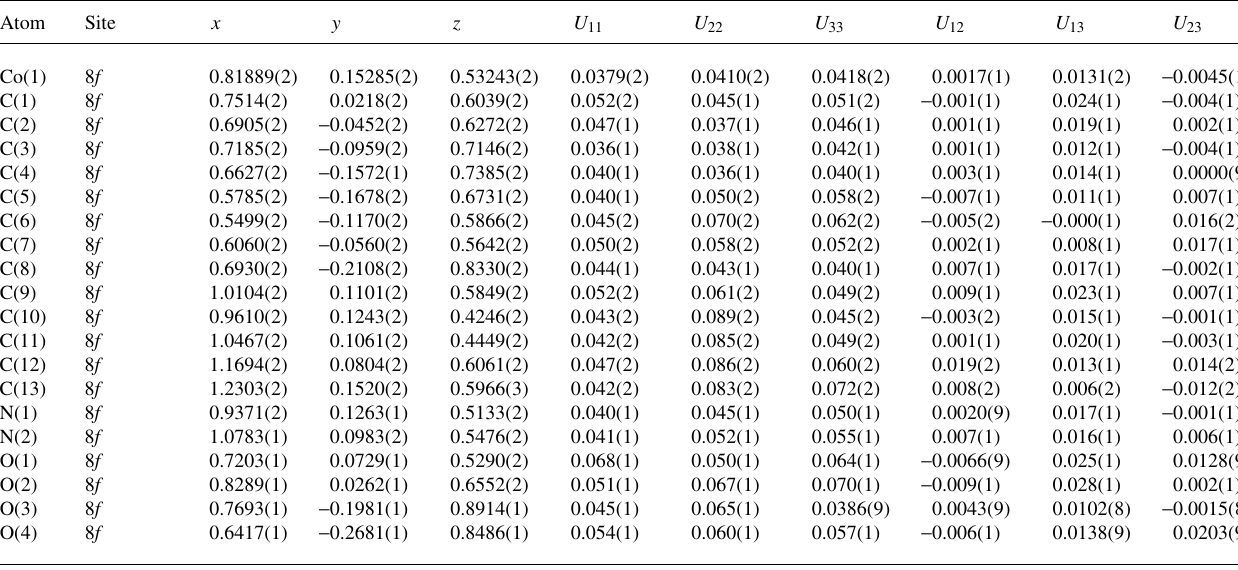
Table 3. Atomic coordinates and displacement parameters (in Å 2 ) .